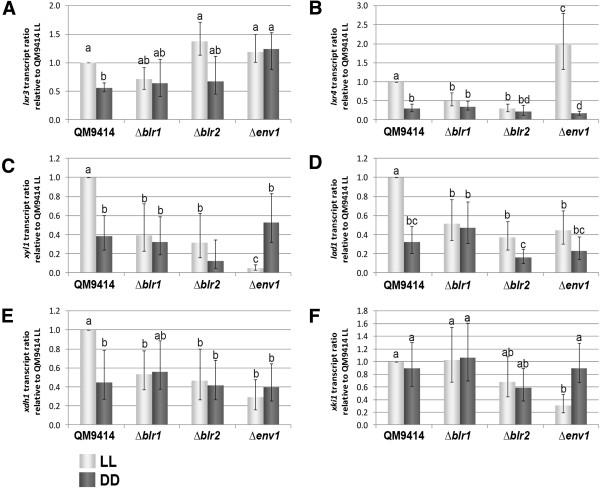
qRT PCR analysis of transcript abundance of genes involved in D-galactose and L-arabinose metabolism. Transcript levels of lxr3(A), lxr4 (B), xyl1 (C), lad1 (D), xdh1 (E) and xki1 (F) were analyzed in constant light (LL) and constant darkness (DD) on cellulose in QM9414, ∆env1, ∆blr1 and ∆blr2. Data from two biological and three technical replicates were included in the calculations. Different letters above the data point reflect statistically significant differential regulation (p-value 0.01; as calculated using the REST software).